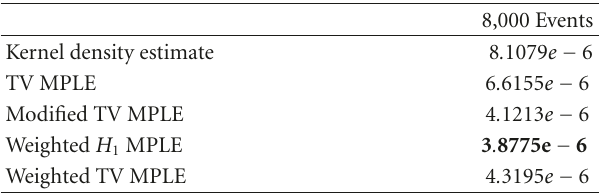
Table 1: This is the L 2 error comparison of the five methods shown in Figure 2. Our proposed methods performed better than both the Kernel Density Estimation method and the TV MPLE method.